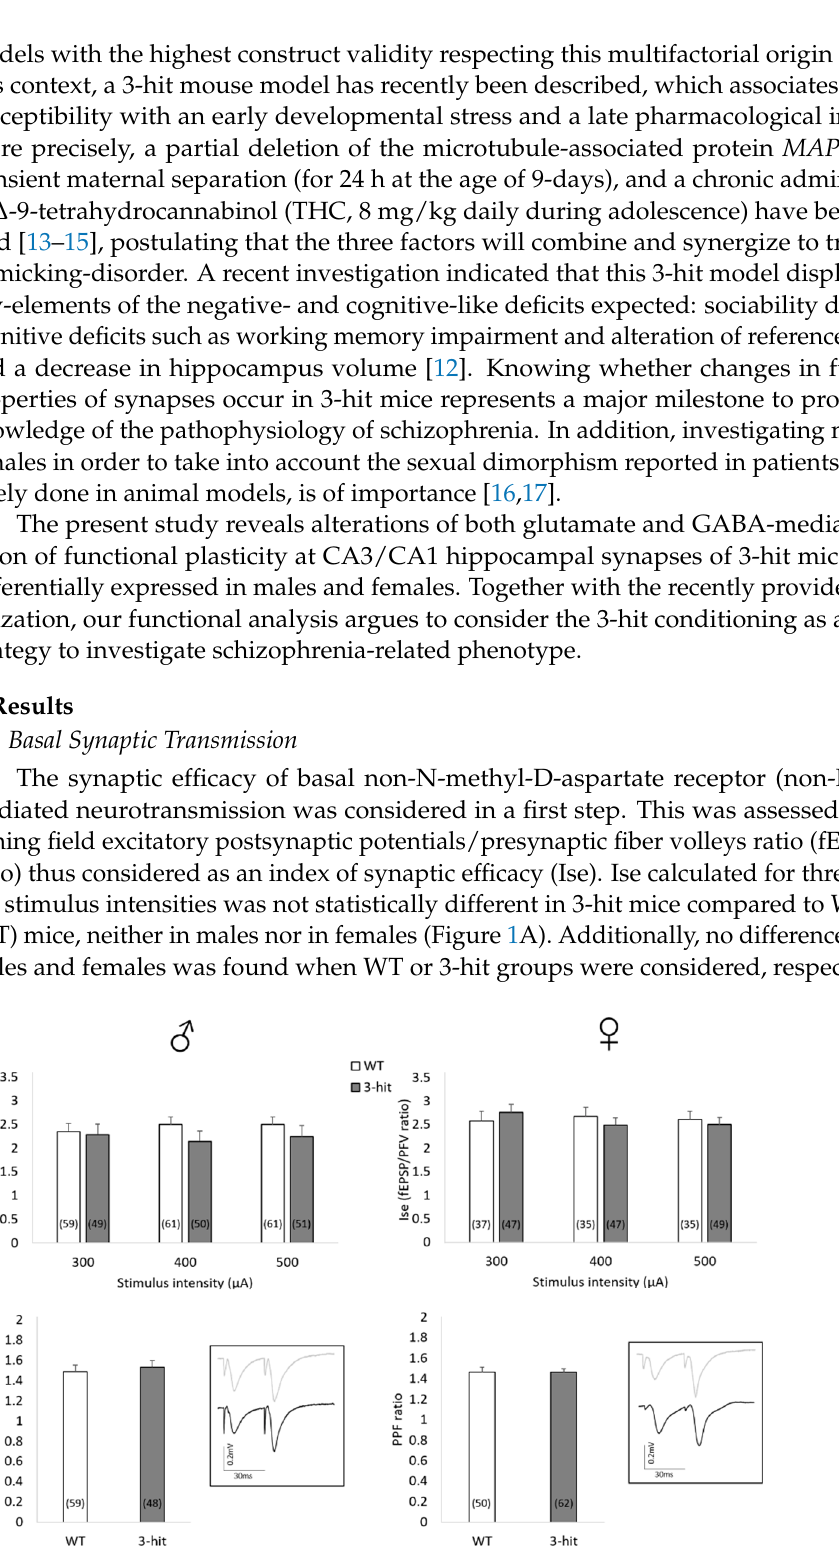
Figure 1. Basal synaptic transmission in CA1 hippocampal area is not impaired in 3-hit mice. ( A ) Index of synaptic efficacy Ise (fEPSP/PFV ratio) in Wild Type (WT) and 3-hit mice, males (left) and females (right), with increasing stimulus intensity. ( B ) Paired pulse facilitation (PPF) ratio in WT and 3-hit mice, males (left) and females (right). In inserts, traces recorded are shown: WT (grey line) and 3-hit (black line) male (left) and a female (right) mouse. The number of slices used in each group is indicated in histogram bars. Represented data are Mean ±